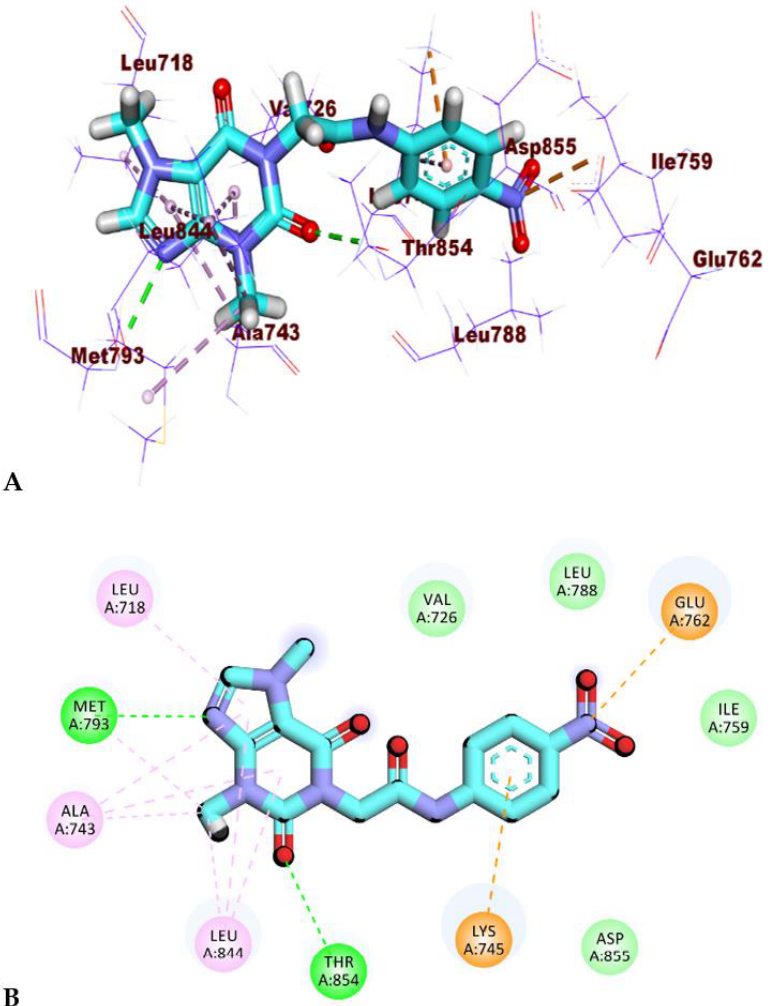
Figure 6. ( A ) 3D and ( B ) 2D interaction pattern of T-2-PNPA with the EGFR T790M active site.